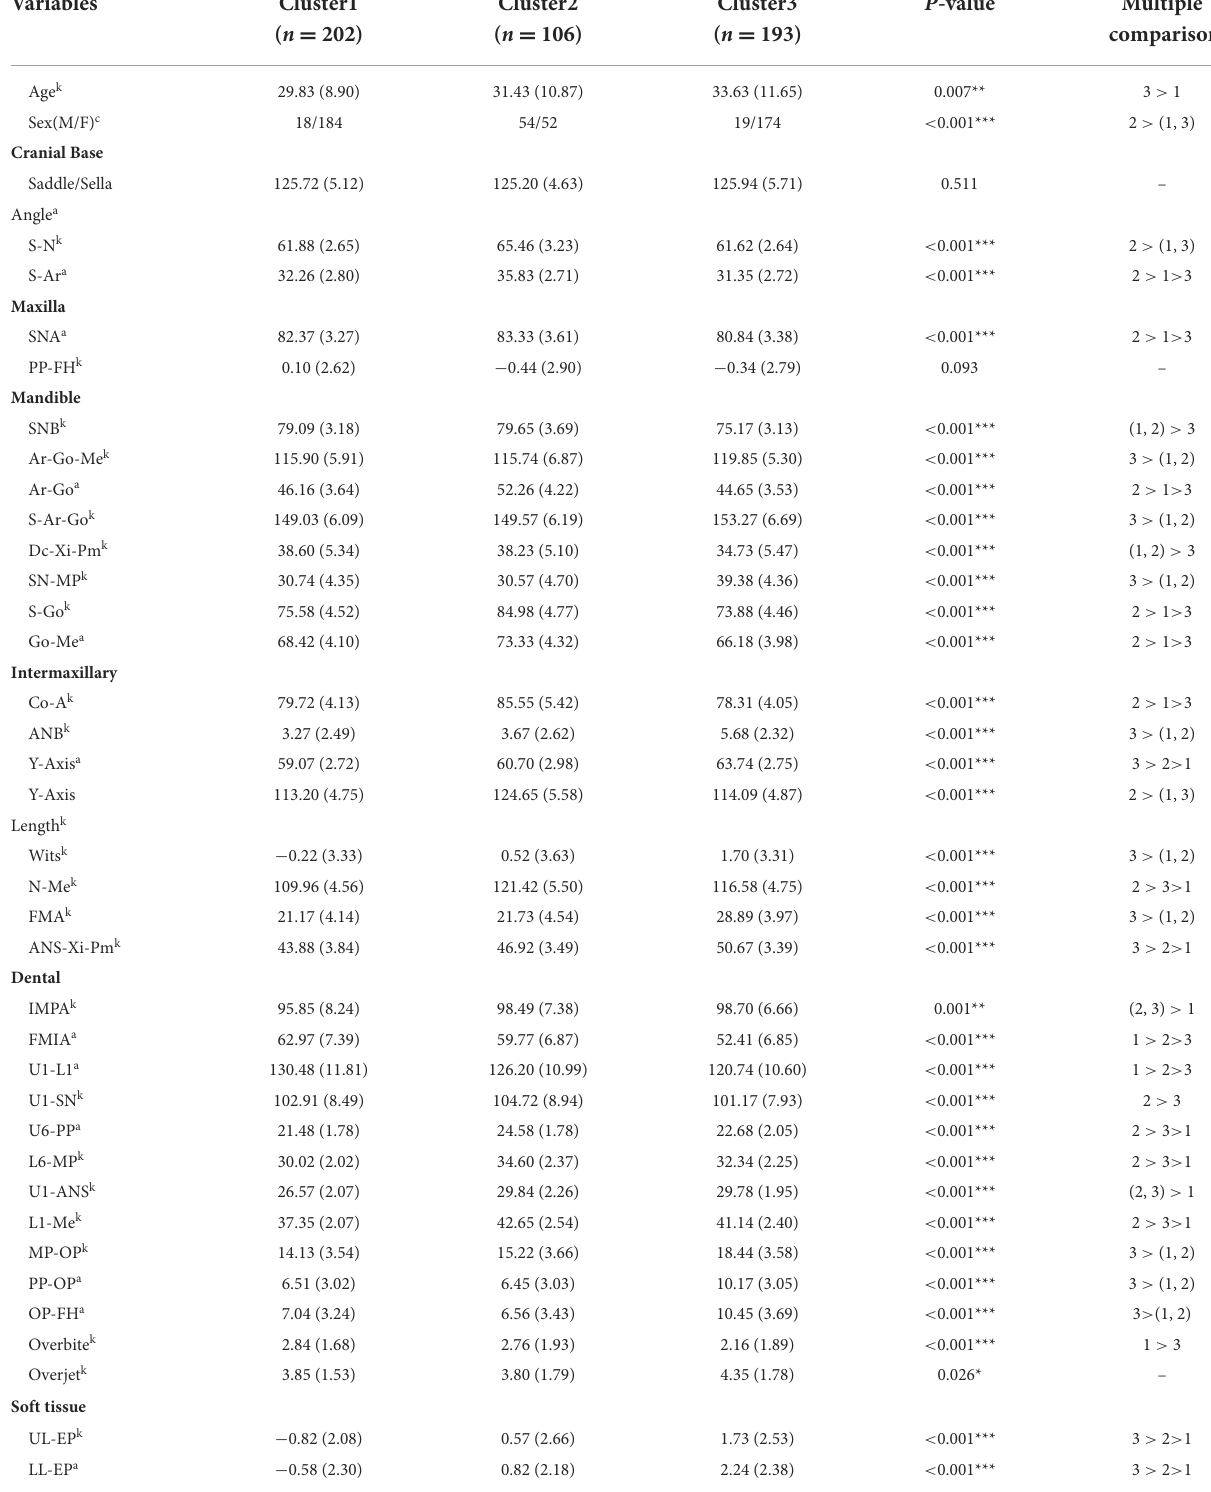
TABLE 4 Comparison of cephalometric variables among three